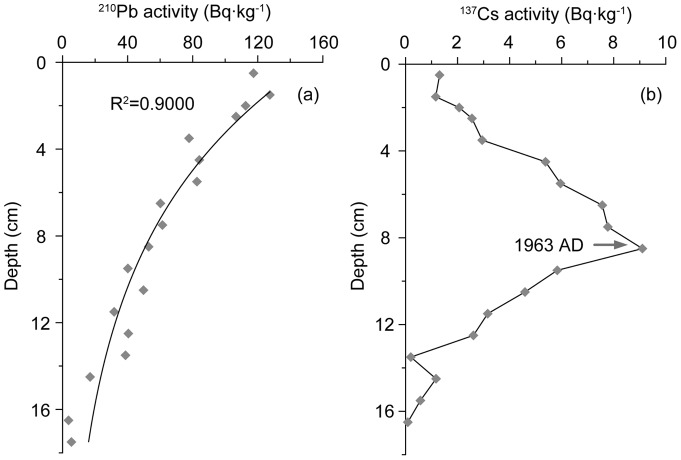
Activity profiles of 210Pb (a) and 137Cs (b) for the sediment core M38002.